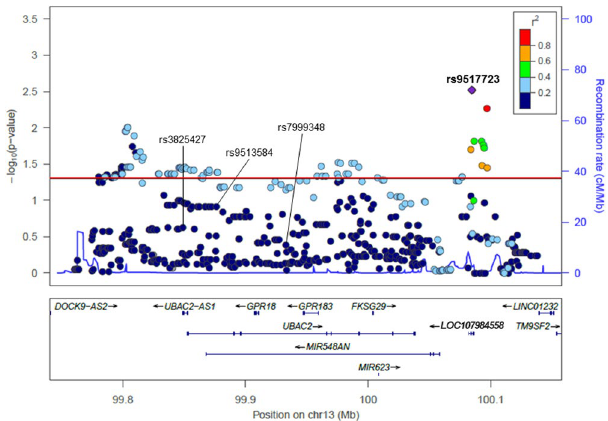
Figure 1. In-depth SNP analysis of the UBAC2 region. The lead SNP (rs9517723) is depicted as a purple diamond. The color coding of all other SNPs indicates linkage disequilibrium (LD) with the lead SNP: red, r 2 ≥ 0.8; yellow, 0.6 ≤ r 2 < 0.8; green, 0.4 ≤ r 2 < 0.6; cyan, 0.2 ≤ r 2 < 0.4; blue, r 2 < 0.2; and gray, r 2 is unknown. The left y axis represents the − log10 P values for allelic association with Behçet’s disease, and the right y axis represents the estimated recombination rate. The horizontal red line indicates the significance level of P = 0.05. Gene annotations are shown below the figure. The plot was created using LocusZoom.